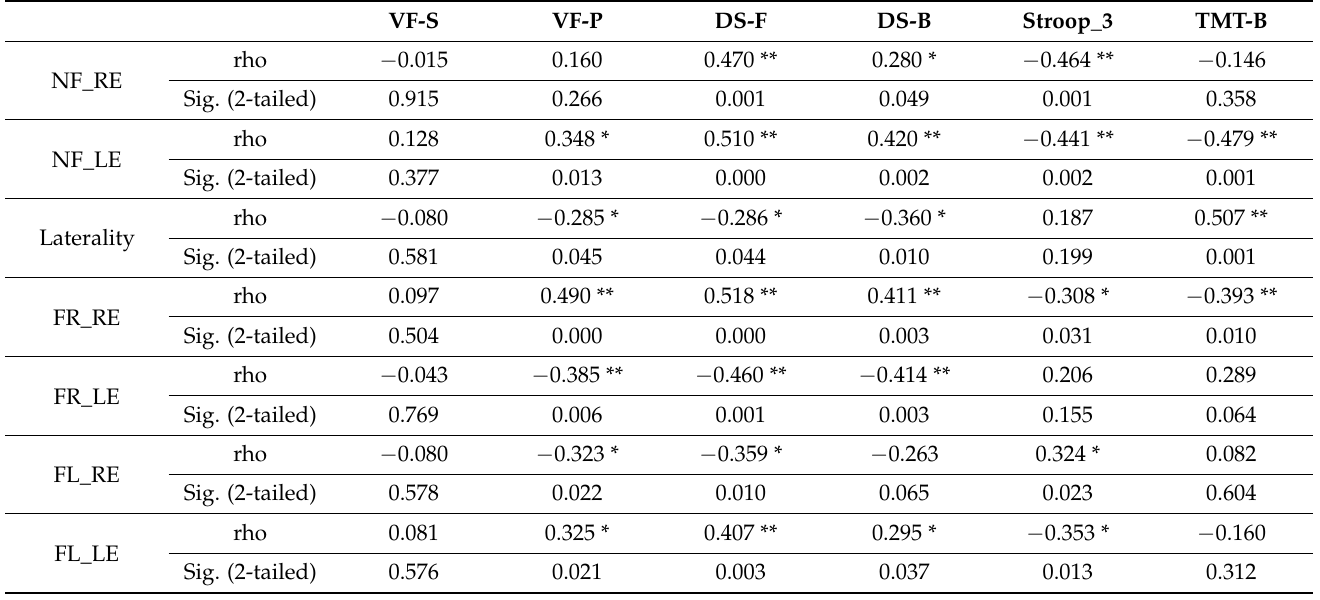
Table 3. Correlations between auditory processing scores and neuropsychological battery